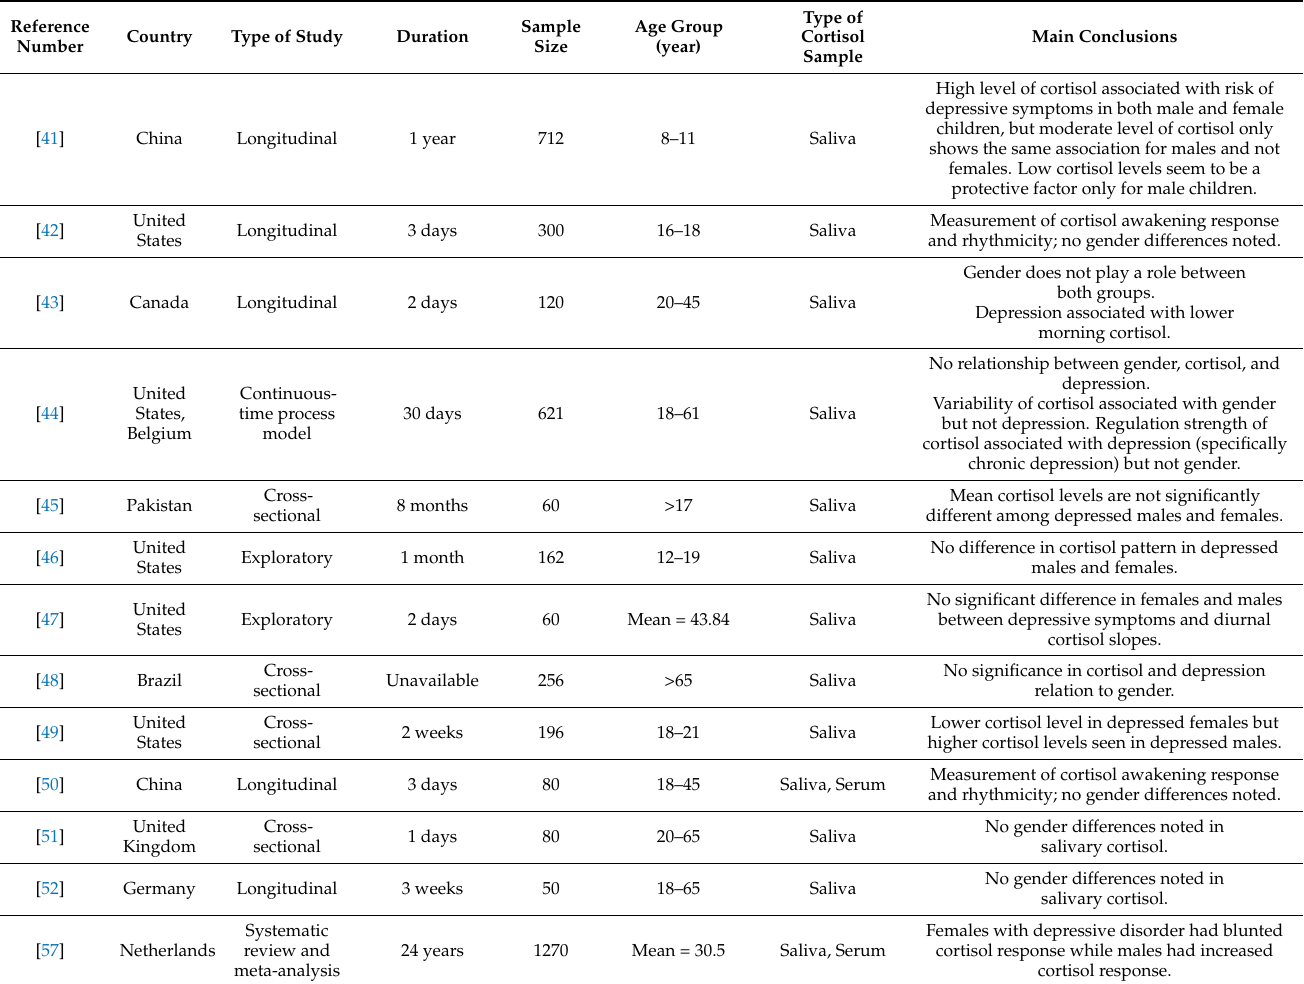
Table 2. Salivary mixed-gender studies investigating the relationship between cortisol and depression.